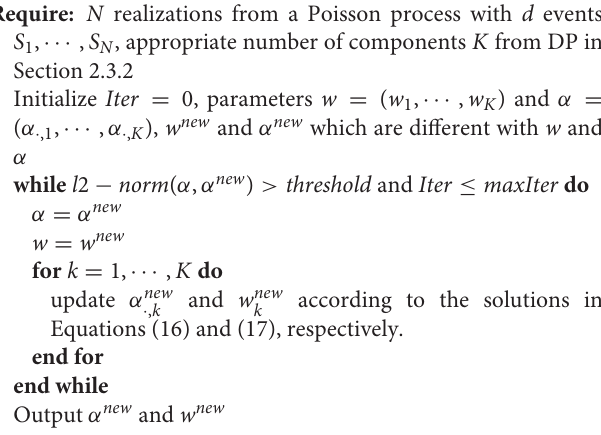
Algorithm 2 Parameter Estimation using the EM